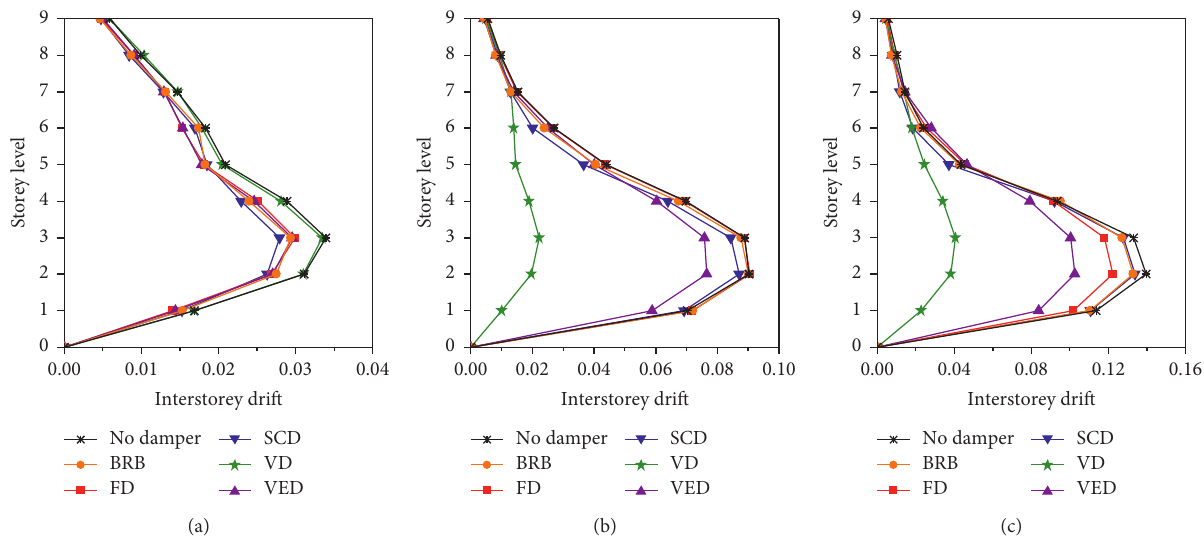
Figure 17: Vibration reduction performance of five typical dampers under different PVAs. (a) PVA � 50cm/s. (b) PVA � 130cm/s. (c) PVA �